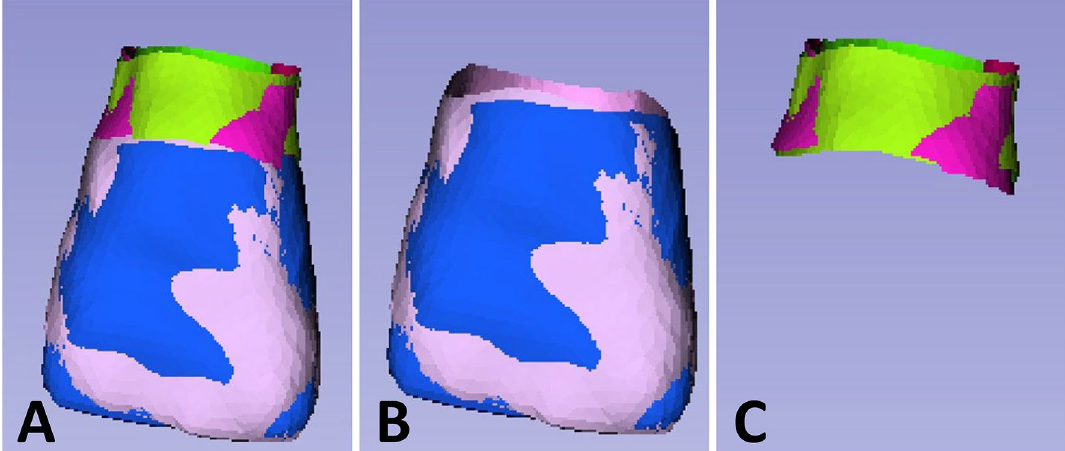
Figure 6. The right element and the left element form a mirrored pair. ( A ), A mirrored pair of crowns with emergence profiles. ( B ), A mirrored pair of crowns. In a mirrored configuration, the blue part indicates one side of the crown, while the pink part indicates the other side of the crown. ( C ), A mirrored pair of emergence profiles. In a mirrored configuration, the green part indicates one side of the emergence profile, while the red part indicates the other side of the emergence profile.